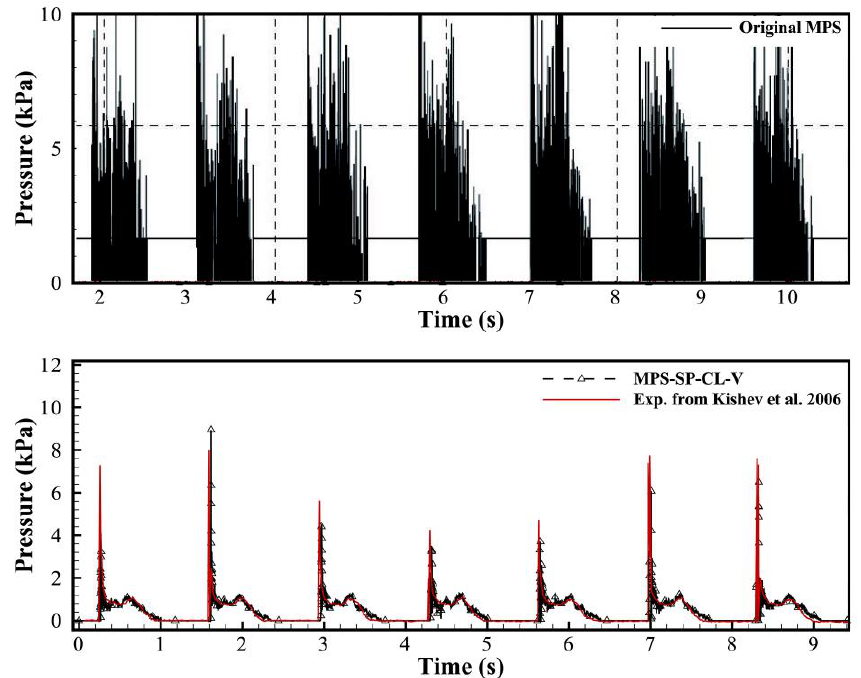
Figure 18. Comparison of the pressure in the experiment of Kishev et al. [44] and the original MPS method of Lee et al. [29].